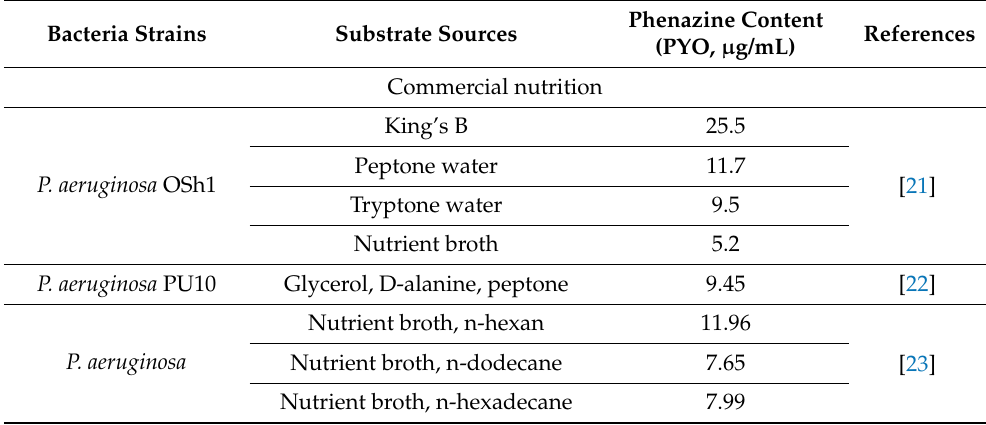
Table 2. Various substrate sources used for phenazine production. Bacteria